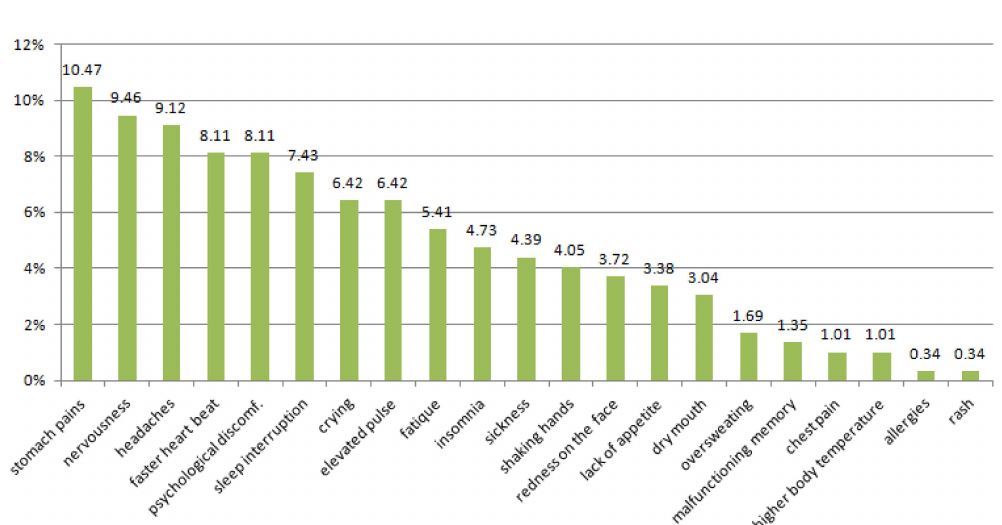
Figure 1. What symptoms of stress do you notice most often in